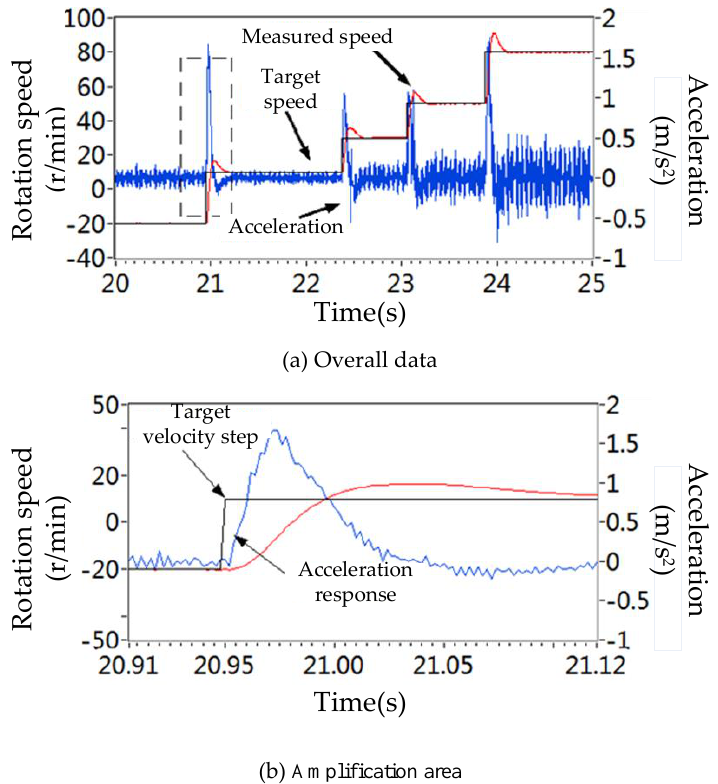
Figure 25. Electrical inertia response time at constant torque.